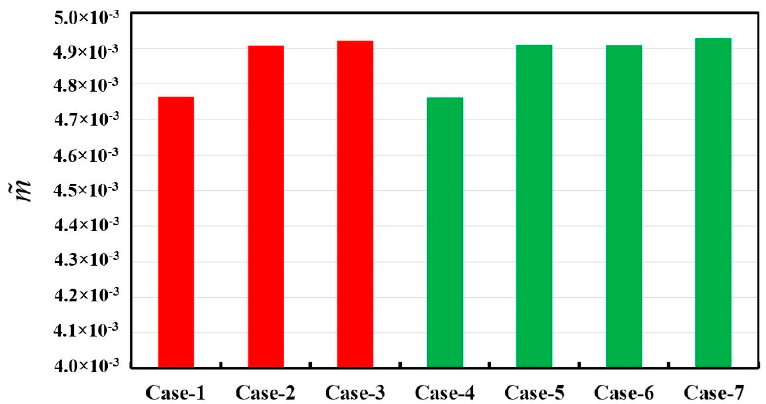
Figure 14. Dimensionless leakage flow rate.